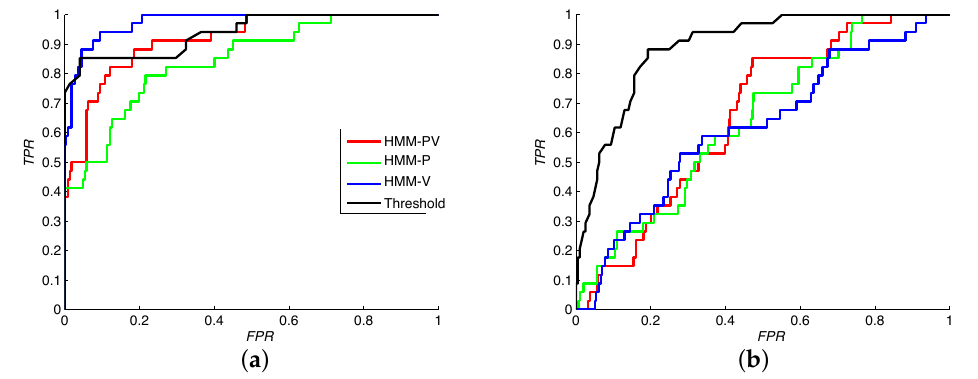
Figure 5. ROC curves obtained for participants ( a ) A2 and ( b ) B1. All classifiers are compared using 3-fold